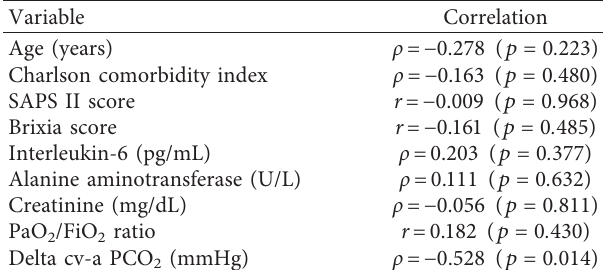
Table 2: Results of the correlation analyses between Delta a-cv lactate and the study